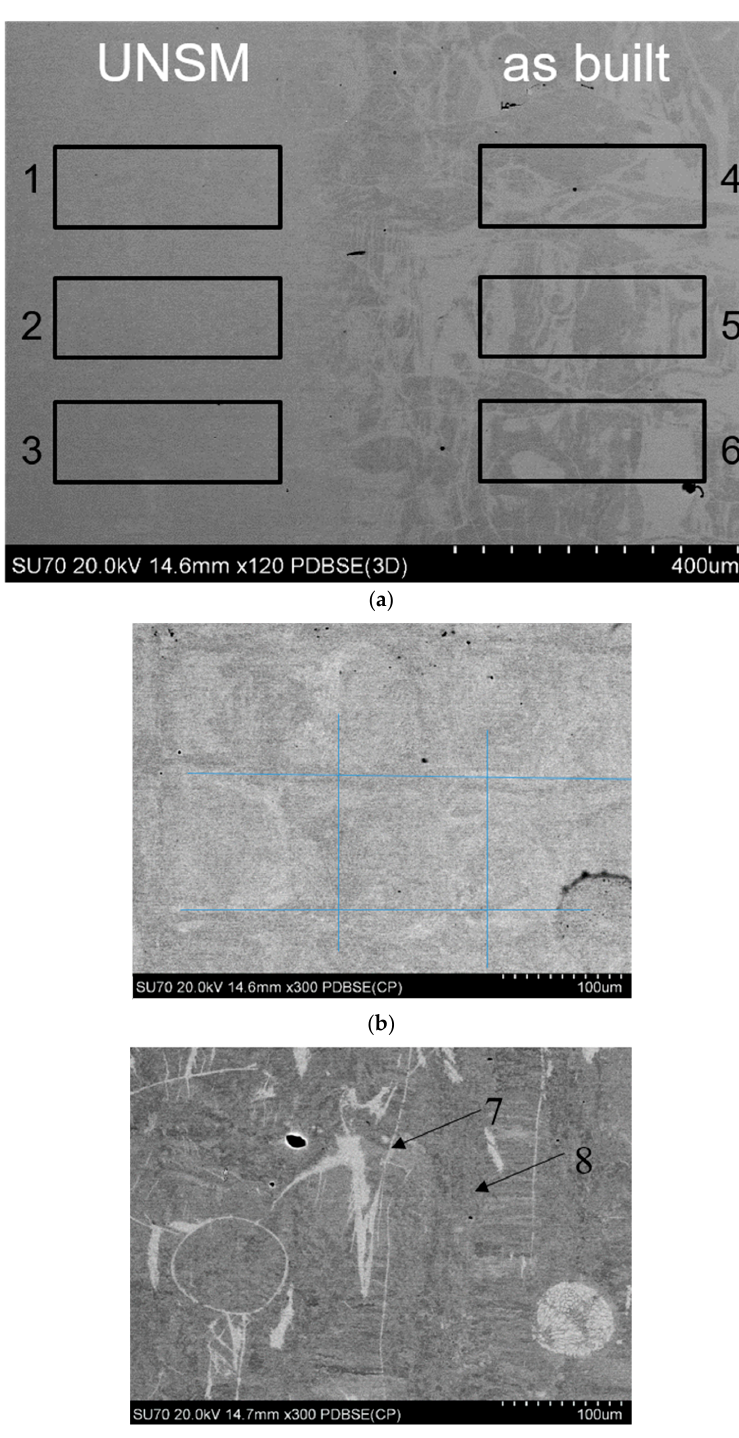
Figure 4. BSE-SEM micrographs in the x–y view: surface containing the border between depicting the UNSMed and the initial surfaces ( a ); higher magnification of the UNSMed ( b ) and as-built surface ( c